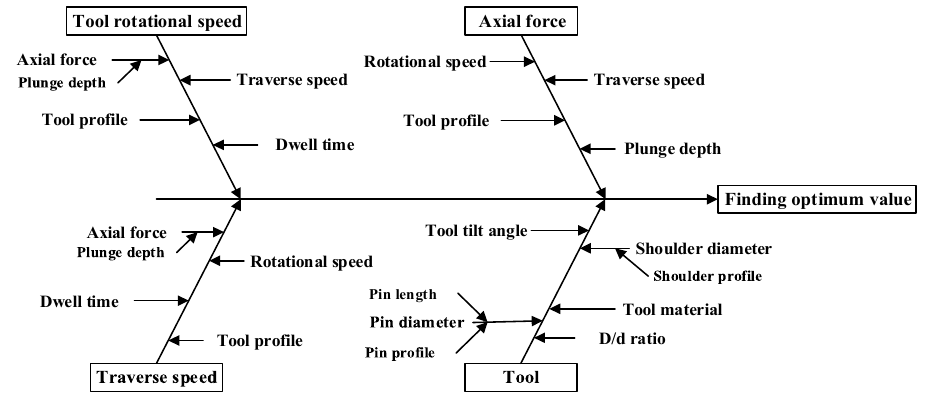
Figure 1. Cause and effect diagram of parameters influencing on FSW joint quality.